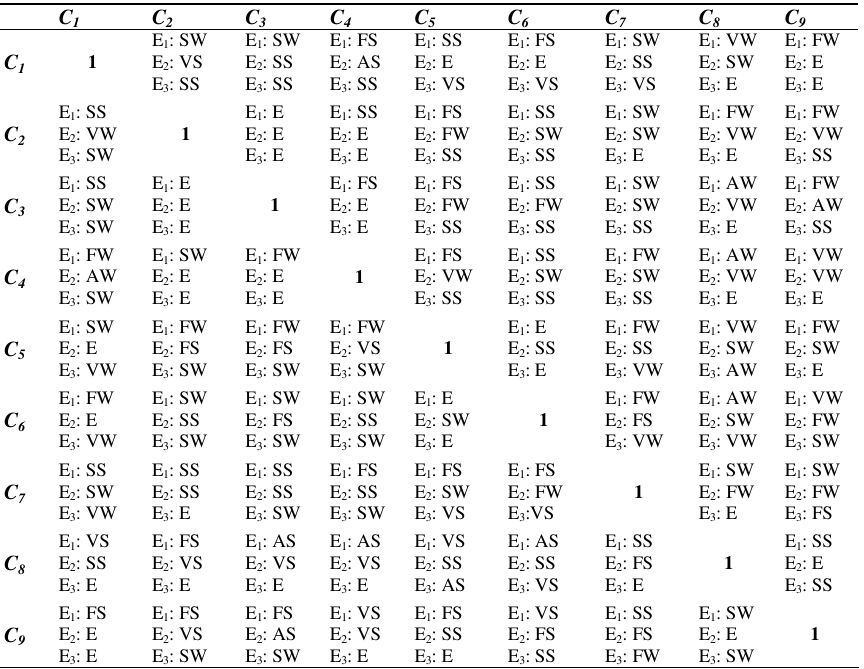
Figure 6. Hierarchical structure of the website quality evaluation problem Table 4 Pairwise comparisons of website quality evaluation